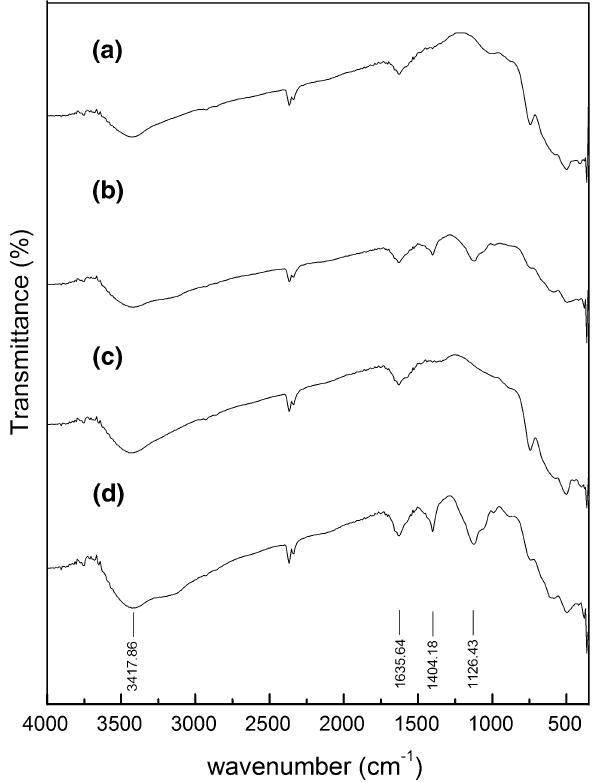
Fig. 6 FTIR spectra of zirconia prepared with and without sulfate and CTAB. a Z, b ZS, c MZ, and d MZS